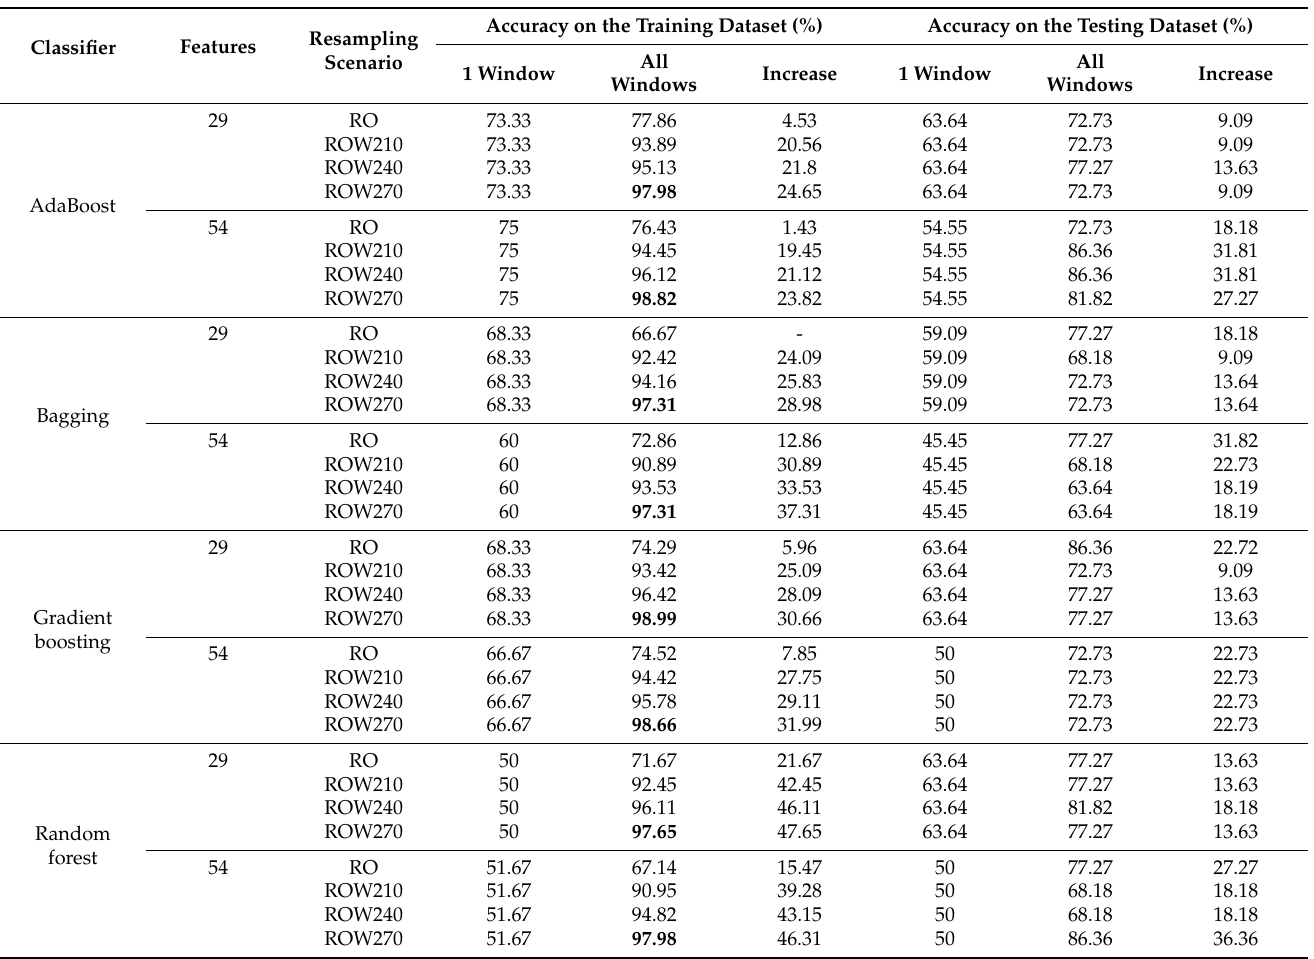
Table 8. The accuracy of the classification models that used 1 window or all windows in the training dataset and testing dataset for 4 resampling scenarios (RO, ROW210, ROW240, and ROW270) with 29 and 54 features. In each classifier with different features and resampling scenarios, the best result in terms of accuracy of the training dataset is shown in